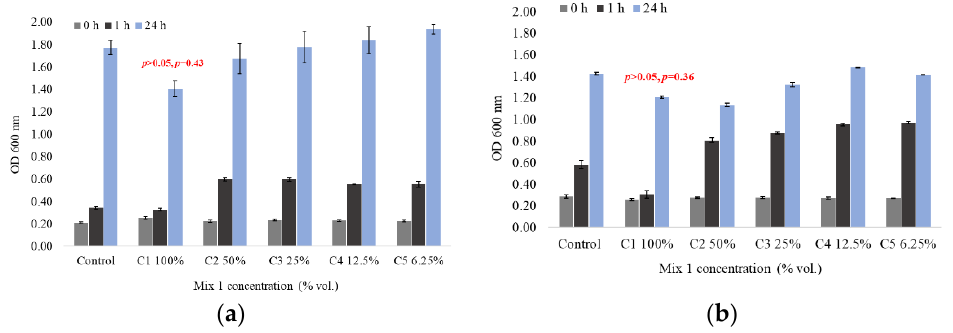
Figure 2. Gram-negative bacterial growth curve in the presence of Mix 1: ( a ) Pseudomonas aeruginosa ; ( b ) Escherichia coli (average ± SD, n = 3). Control — bacterial strains in growth LB medium without Mix 1; Bacterial strains with Mix 1 serial dilutions from 1890 mg SO 42 − /L (C1 100%), 945 mg SO 42 − /L (C2 50%), 472.5 mg SO 42 − /L (C3 25%), 236 mg SO 42 − /L (C4 12.5%) and 118 mg SO 42 − /L (C5 6.25%).